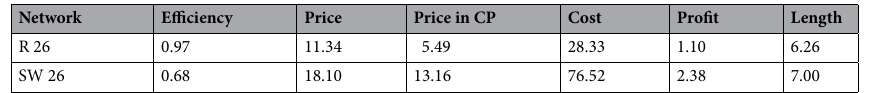
Table 1. Experimental results. Efficiency (fraction of rounds in which the cheapest path cost was equal to or less than the threshold), and mean values of the price, price in the cheapest path, cost of the cheapest path, profit, and cheapest path length for the random network with 26 nodes (R 26) and for the small-world network with 26 nodes (SW 26).